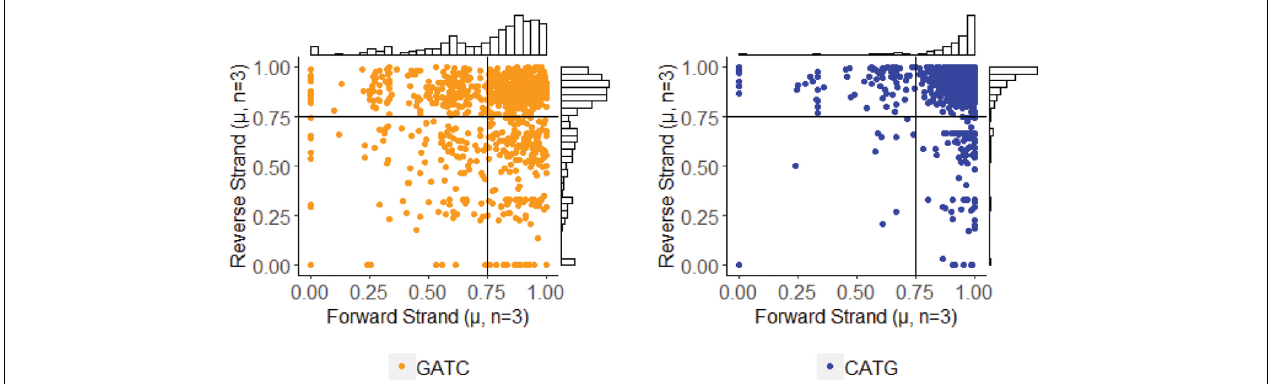
FIGURE 5 | Methylation status of GATC and CATG palindromes across three sequenced replicates of PBCV-1. The status for the forward and reverse strand of a single palindrome are plotted for the separated motifs without variation information. Histogram plots provide an estimate of how many events occur with the given coordinates, with lines marking thresholds for defining complete methylation, hemimethylation, and stochastic methylation. A threshold of methylation in 75% of reads is typically used by PacBio for positive identification of methylation.